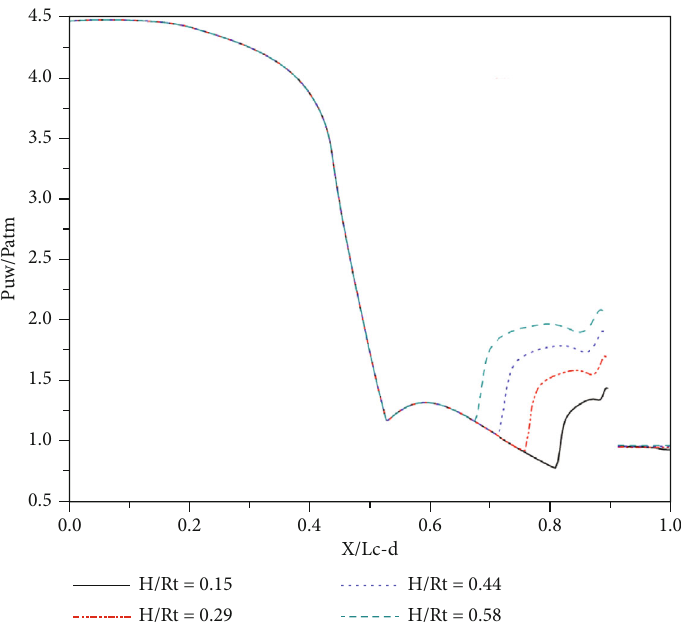
Figure 8: Static pressure distributions along the top wall for diverse rod penetration heights ( NPR = 4 : 6 and X